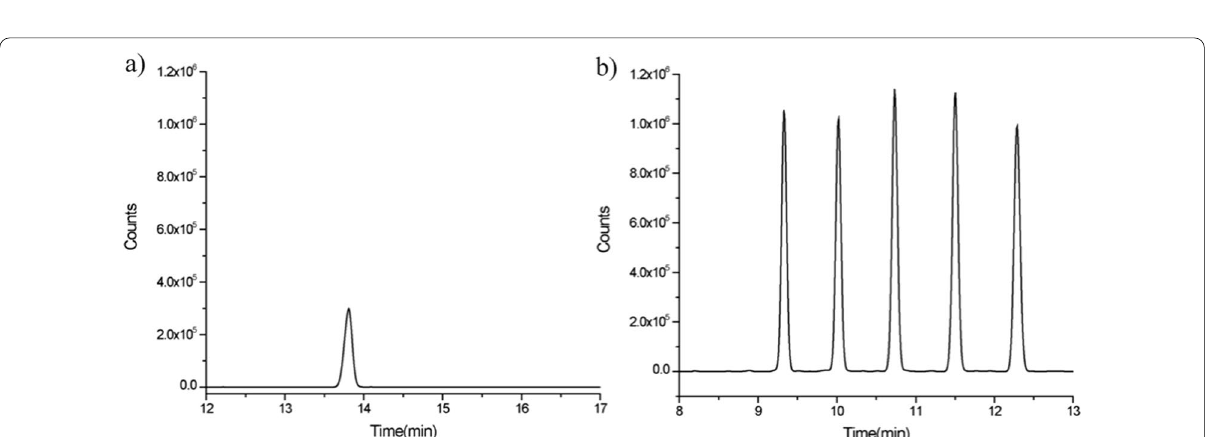
Fig.5 comparison of the normal method ( a ) and the developed method ( b ). Injection concentration of the normal method and the developed method was 2.5 μg/mL and 0.25 μg/mL, respecitively, taking Cys as an